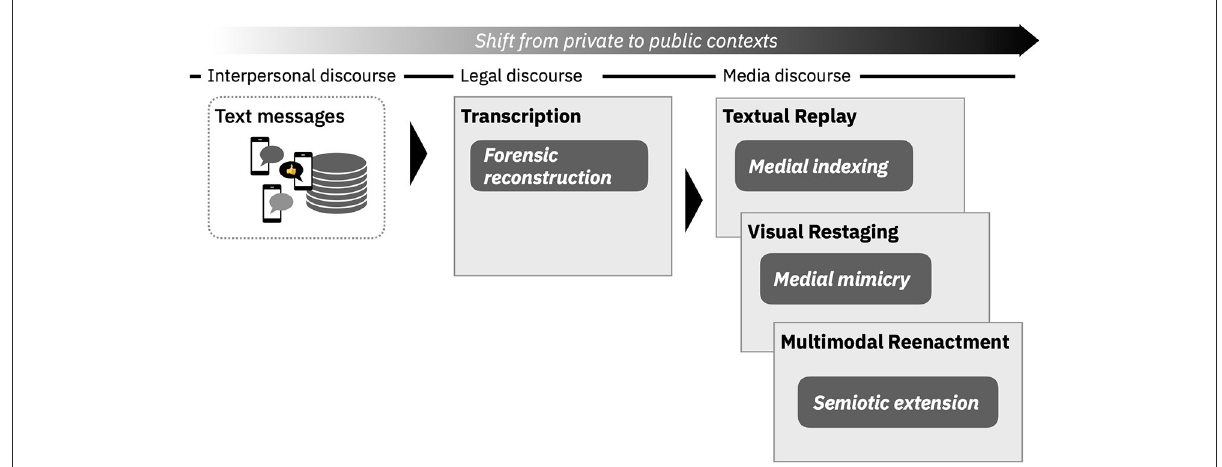
FIGURE1 Modes of cross-media